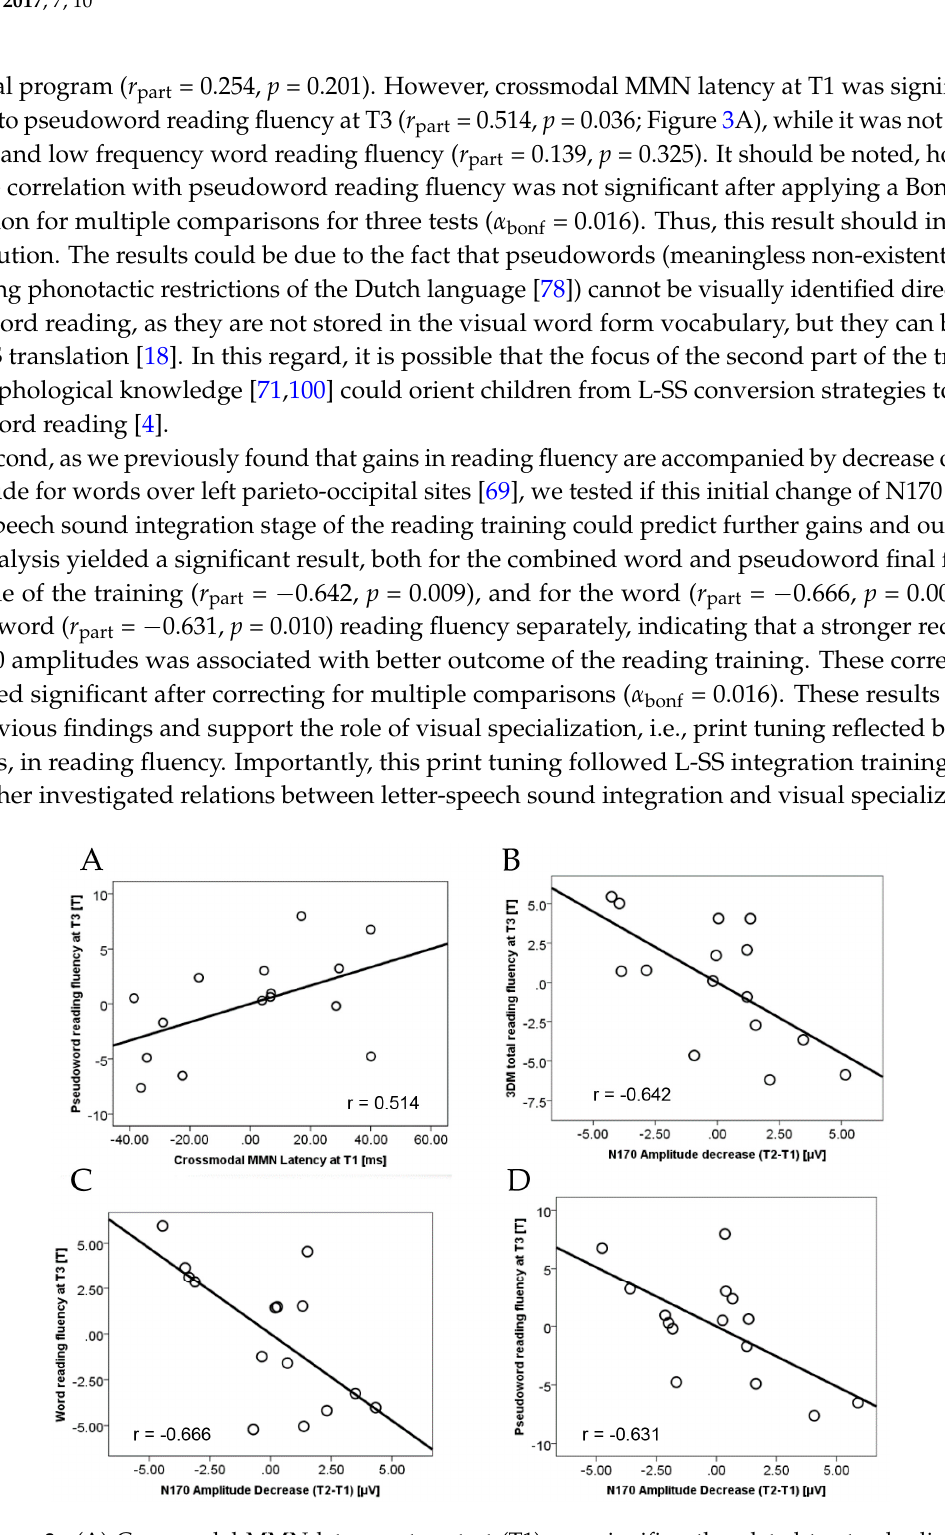
Figure 3. ( A ) Crossmodal MMN latency at pretest (T1) was significantly related to standardized pseudoword reading fluency scores at the end of the training (T3) when controlling for pseudoword reading fluency at T1 and number of sessions. ( B ) Decrease in N170 amplitude from pretest (T1) to the end of the first part of the letter-speech sound training (T2) was significantly related to the combined word and pseudoword, and ( C ) word and ( D ) pseudoword reading fluency scores at the end of the training (T3) when controlling for the appropriate fluency scores at T1 and number of sessions.